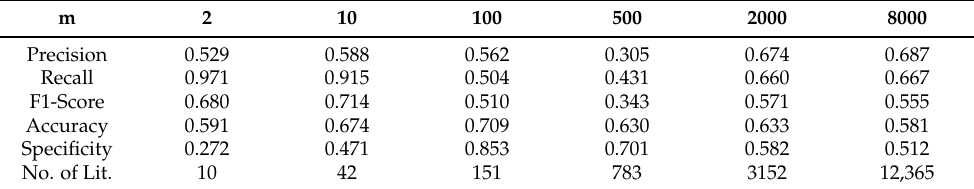
Table 21. Performance of TM with SSL continuous feature scheme on Heart Disease dataset.